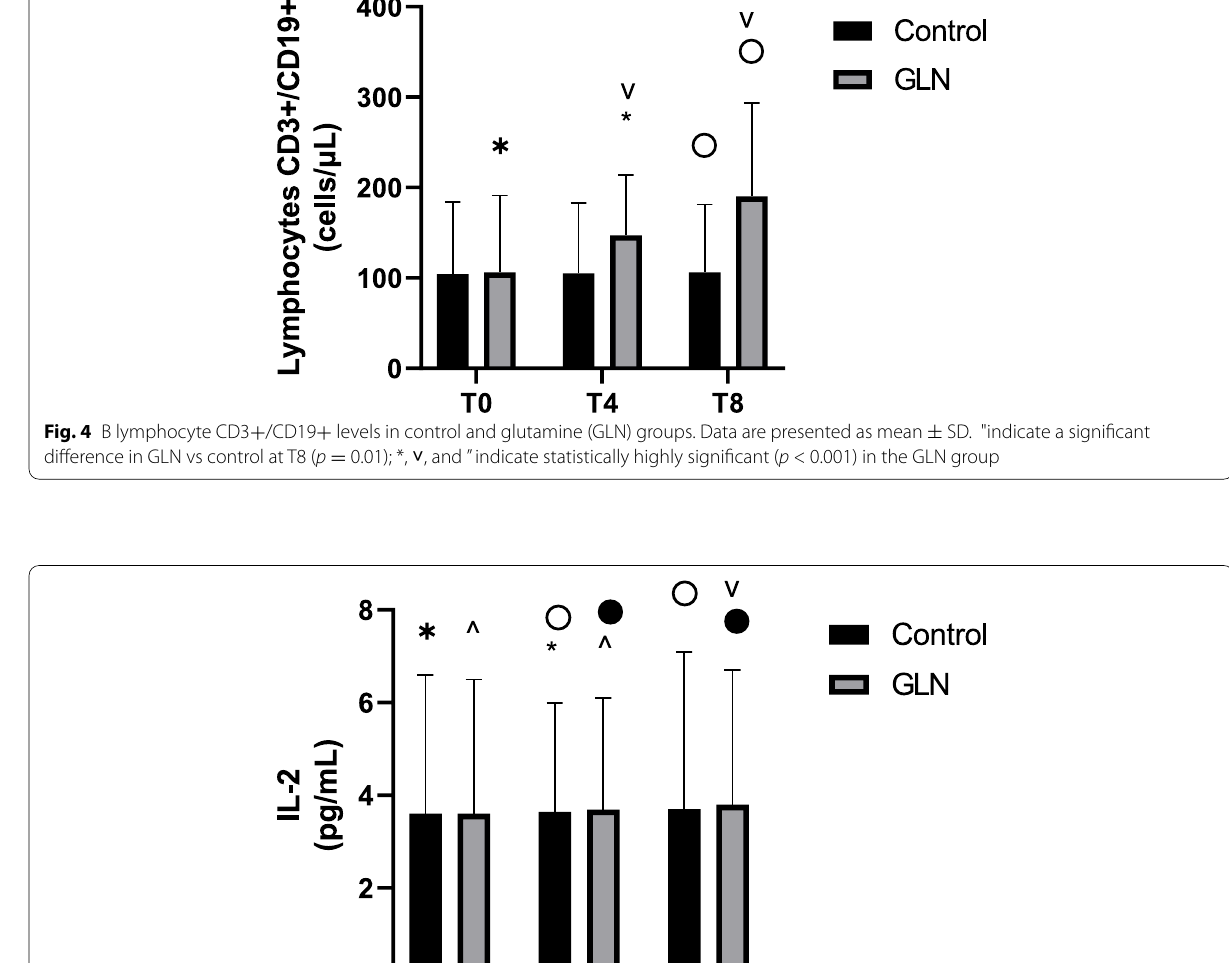
SD. ^, •, and ˅ indicate a significant difference in the GLN ± 0.002) and T4 and T8 ( p = =